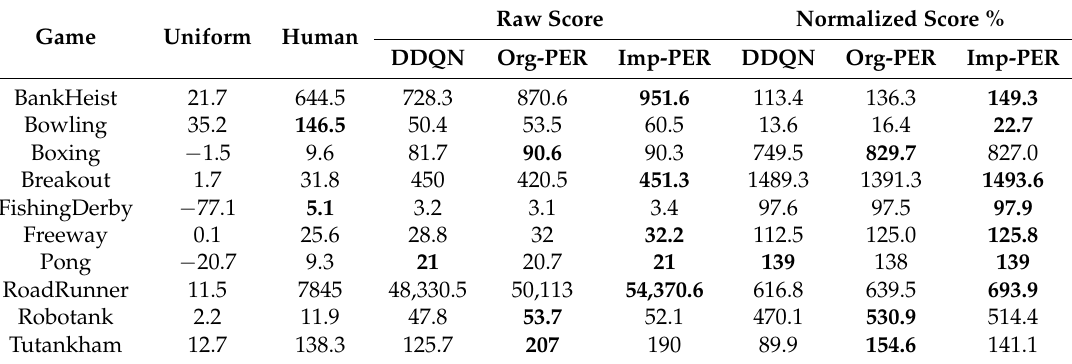
Table 6. Final score and normalized score comparison of all methods on Atari. The best scores are shown in bold font. The uniform and human score are from deepmind [9]. Bold font shows the best performance.